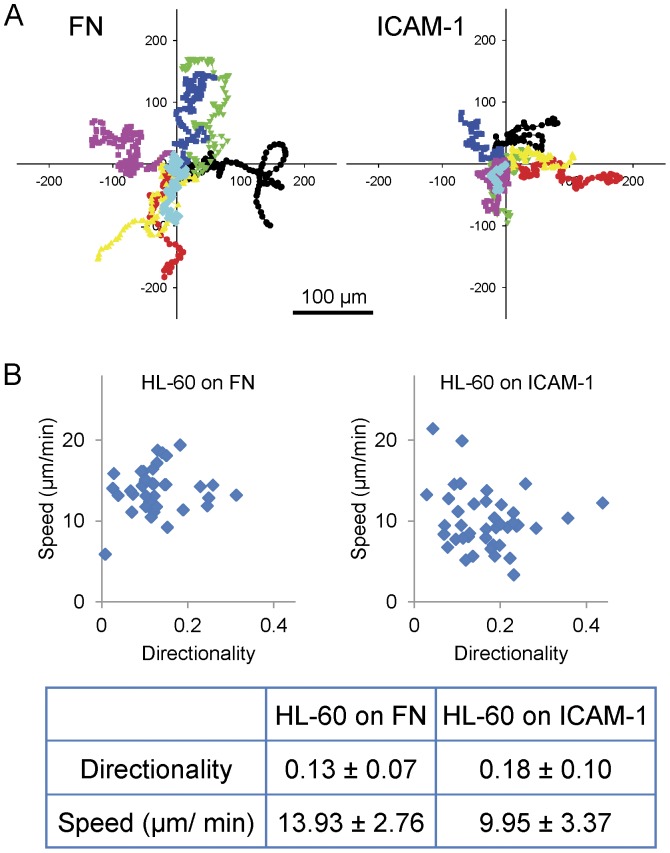
HL-60 migration on FN or ICAM-1.(A) Migration tracks of HL-60 cells on the indicated substrate over 1 hour were translated to a common origin and marked with a different color. Scale Bar  = 100 µm. (B) The speed and directionality were calculated and plotted (n = 36, 39 cell tracks, respectively). At least three independent experiments were quantified. P value  = 3×10−7.